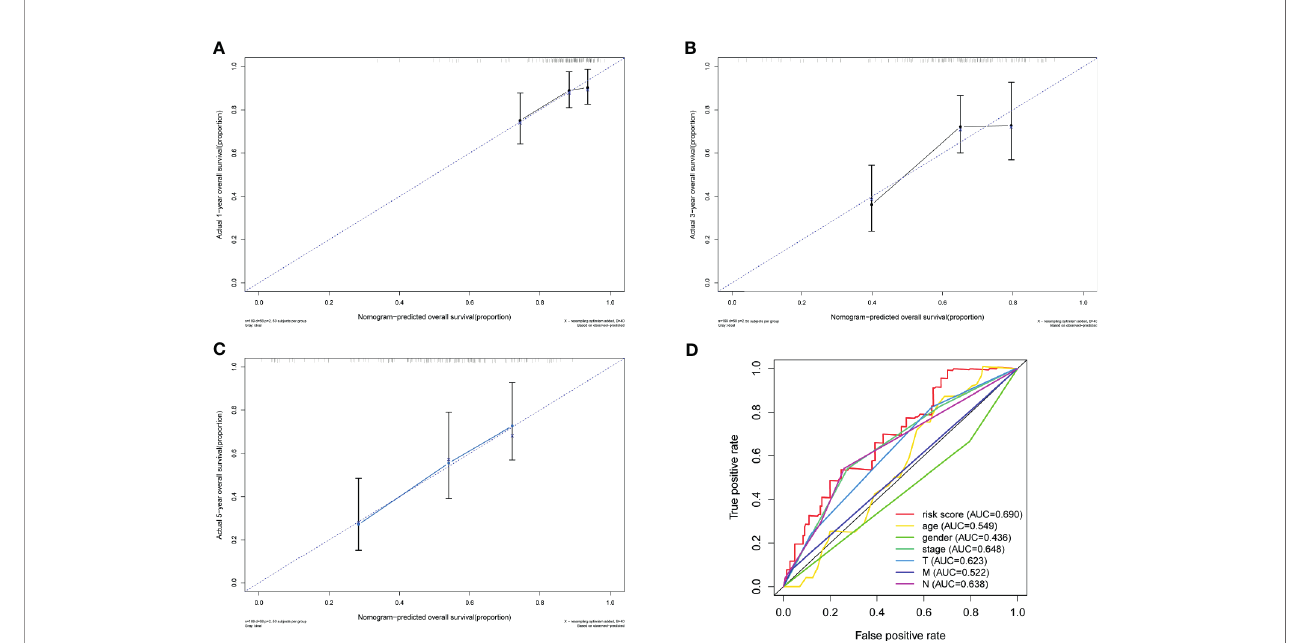
FIGURE 7 | Validation of nomogram. Calibration curves of the nomogram prediction of 1-year (A) , 3-year (B) , and 5-year (C) OS of patients in TCGA – BLCA cohort. (D) ROC curve of the risk score and other relevant clinical parameters. OS, overall survival; TCGA, The Cancer Genome Atlas; BLCA, bladder cancer; ROC, receiver operating